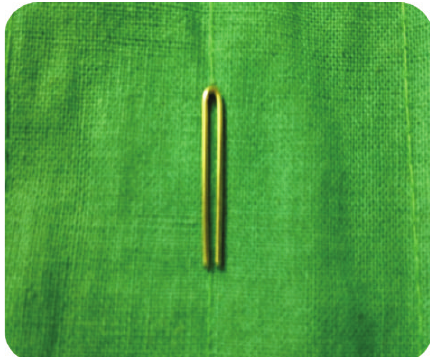
Figure 2: Preoperative radiograph showing teeth 51, 52, 61, and 62.